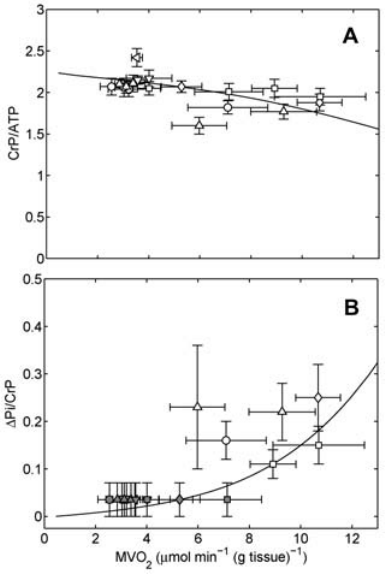
Figure 2. Steady-state phosphate me- tabolites in the canine heart measured by 31 P-MRS. (A) CrP/ATP is plotted versus cardiac oxygen consumption rate (MVO 2 ). (B) D Pi/CrP is plotted as a function of MVO 2 . Solid lines indicate model predictions from [31]; data are adapted from: # , Zhang et al. [14]; v , Zhang et al. [15]; e , Gong et al. [16]; n , Ochiai et al. [17]; , , Gong et al. [18]; % , Bache et al. [19]. This figure is adapted from Wu et al. [31], with permission. Shaded data points indicate situation when Pi is below limit of detection. D Pi, the measured increase over baseline (here normalized to the CrP signal). The shaded data points in Figure 2B corre- spond to the cases where Pi falls below the limit of detection, which is approximately 1 mM [19]. The range of D Pi/CrP indicated by the error bars for those data points corresponds to the range of zero to the limit of detection. It is possible that the baseline signal identified as Pi by Katz et al. [9] was due to 2,3-diphosphoglycerate in the blood pool of the left ventricle cavity. Regardless,